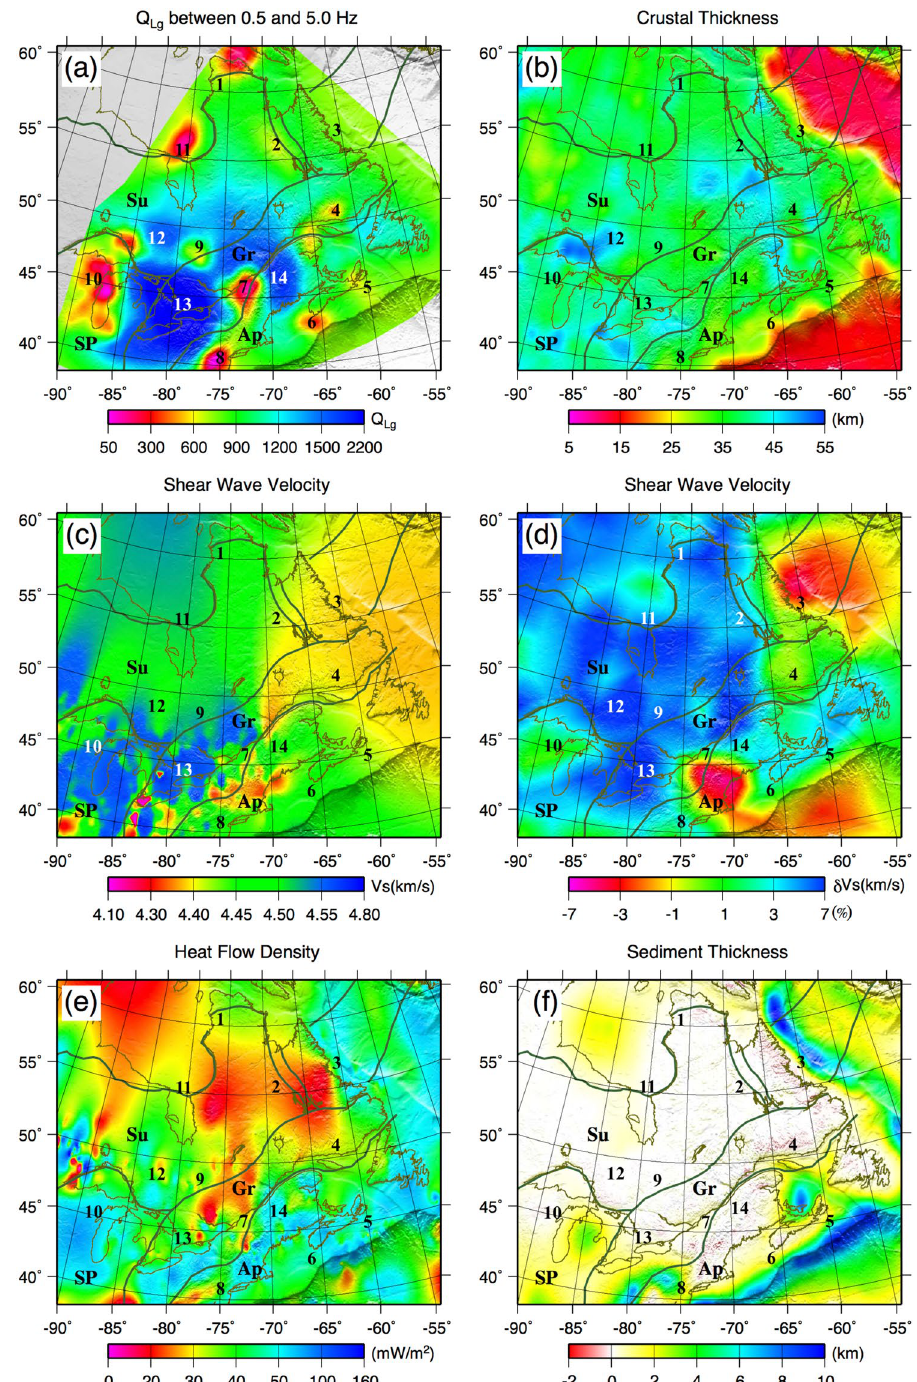
Figure 7. ( a ) The average Q Lg in logarithmic scale between 0.5 and 5.0 Hz, ( b ) crustal thickness based on CRUST1.0 model 83 , ( c ) shear wave velocity model 78 at 60 km depth, ( d ) dVs model 44 at 60 km depth, ( e ) estimated heat flow density at a depth of 100 km 84 , and sediment thickness 83 , along with major geological provinces; Superior (Su), Grenville (Gr), Appalachian (Ap), and Southern (SP). The figure is generated from GMT, which is an open source software available at: